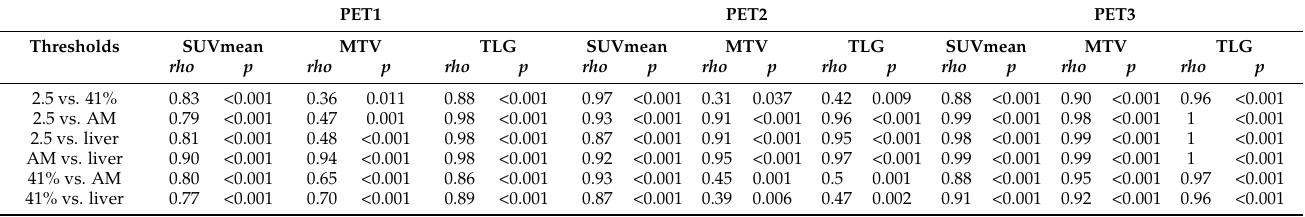
Table 2. Comparison of different absolute threshold values by means of linear regression.